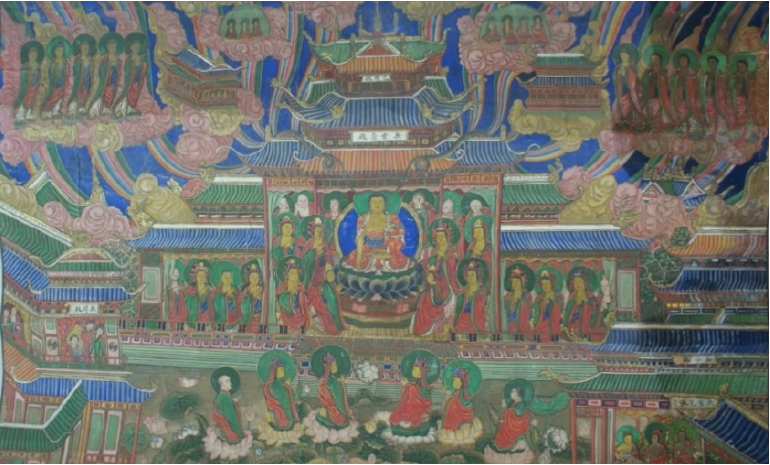
Figure 15. Detail of Three Gates in a Single Mind showing Buddha’s assembly in the central frame. Photograph by Choi Yeub.